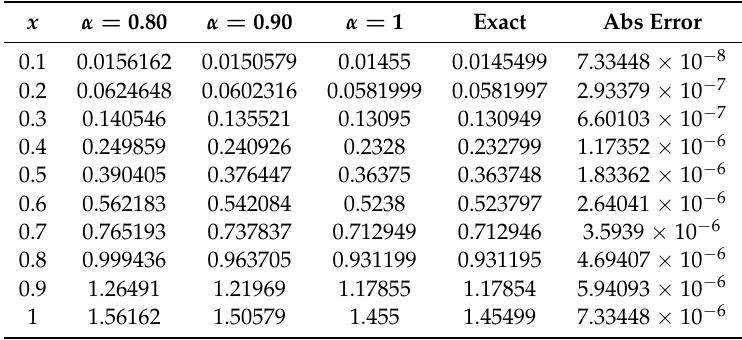
Table 4. Third order approximate results for different values of α at t = 0.75 of Example 1.